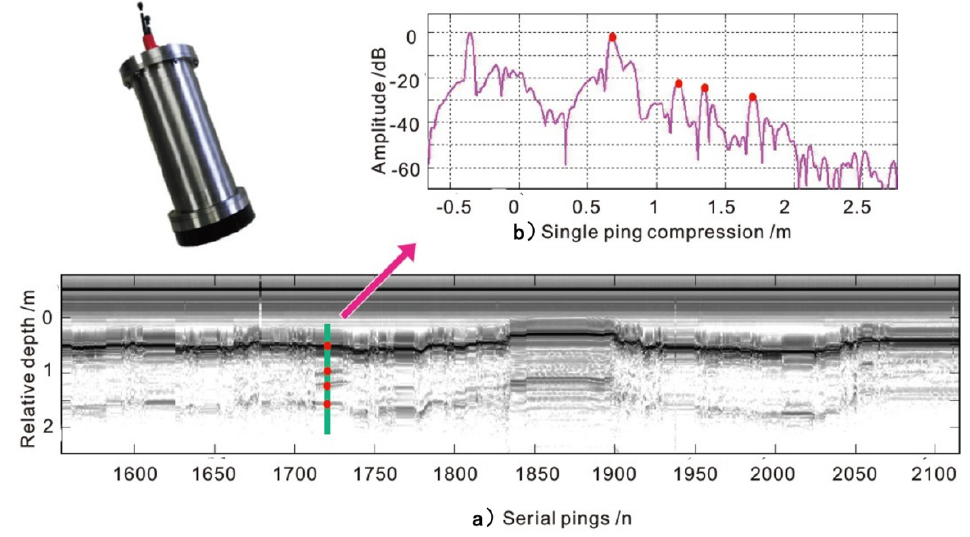
Figure 19. ( a ) HFSSP data in survey line and with ( b ) single ping compression.